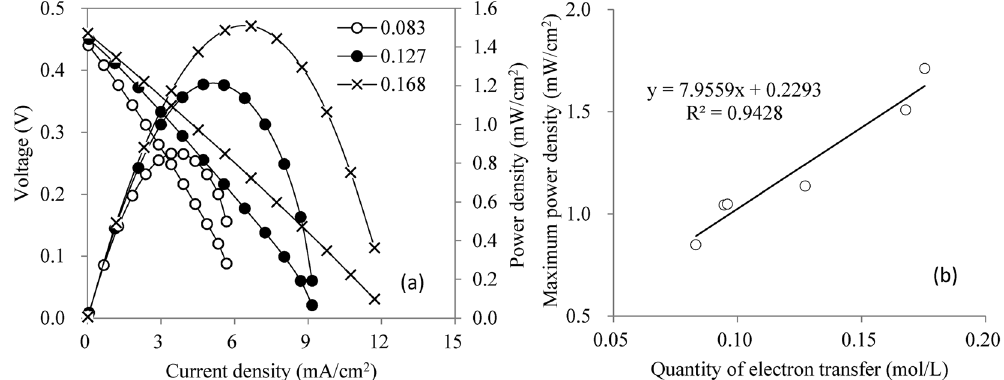
Figure 8. Performance of the LCFC using PW 12 with different reduction degrees ( a ) performance corresponding to the electron transfer numbers of 0.083, 0.127 and 0.168 mol/L, respectively; ( b ) the relation between maximum power density and the numbers of electron transfer).